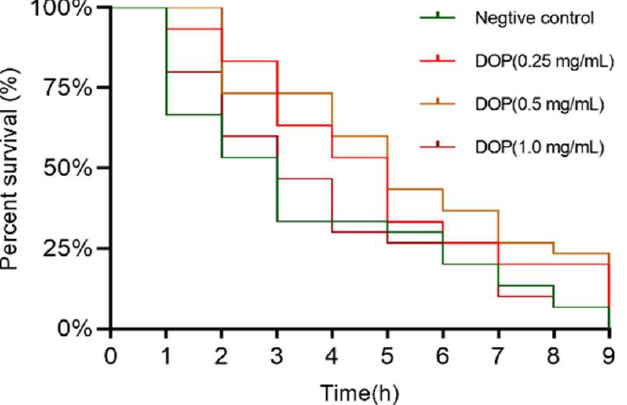
Figure 4. The effects of DOPs on the lifespan assay of C. elegans under PQ stress conditions. Table 3. The effects of DOPs on the lifespan of C. elegans under oxidative stress conditions. Mean Survival Time (h) Median Survival Time (h) Max (h)